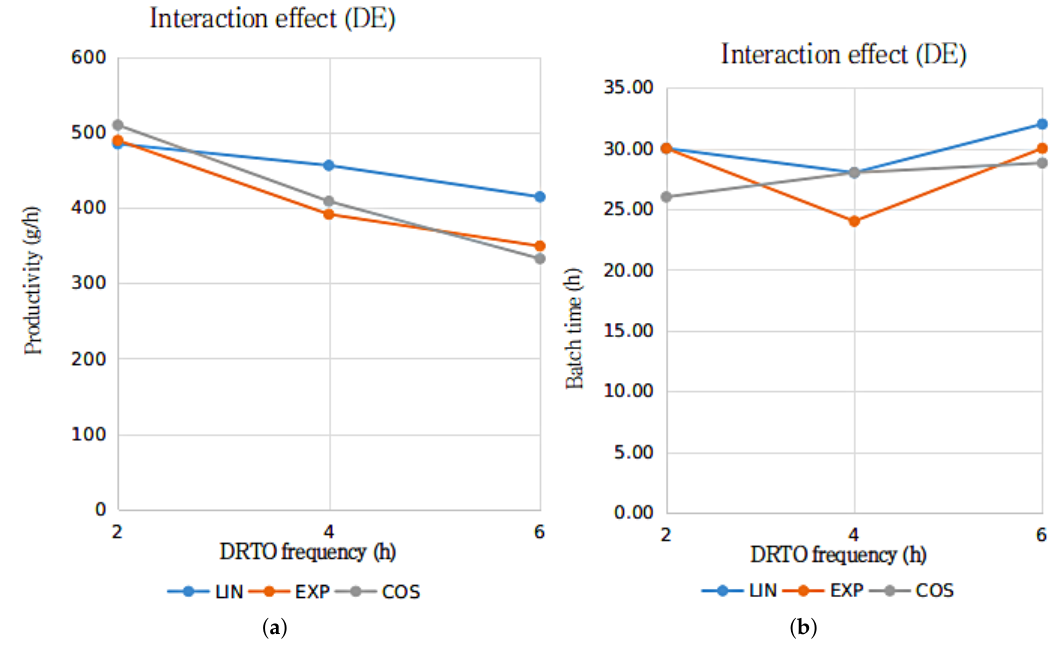
Figure 7. Interactions graph for the ethanol productivity ( a ) and batch duration time ( b ) with the parametrization profile (LIN—linear, EXP—exponential and COS—cosinoidal) and DRTO interval (2, 4 or 6h) as the analyzed factors, using DE as the optimization